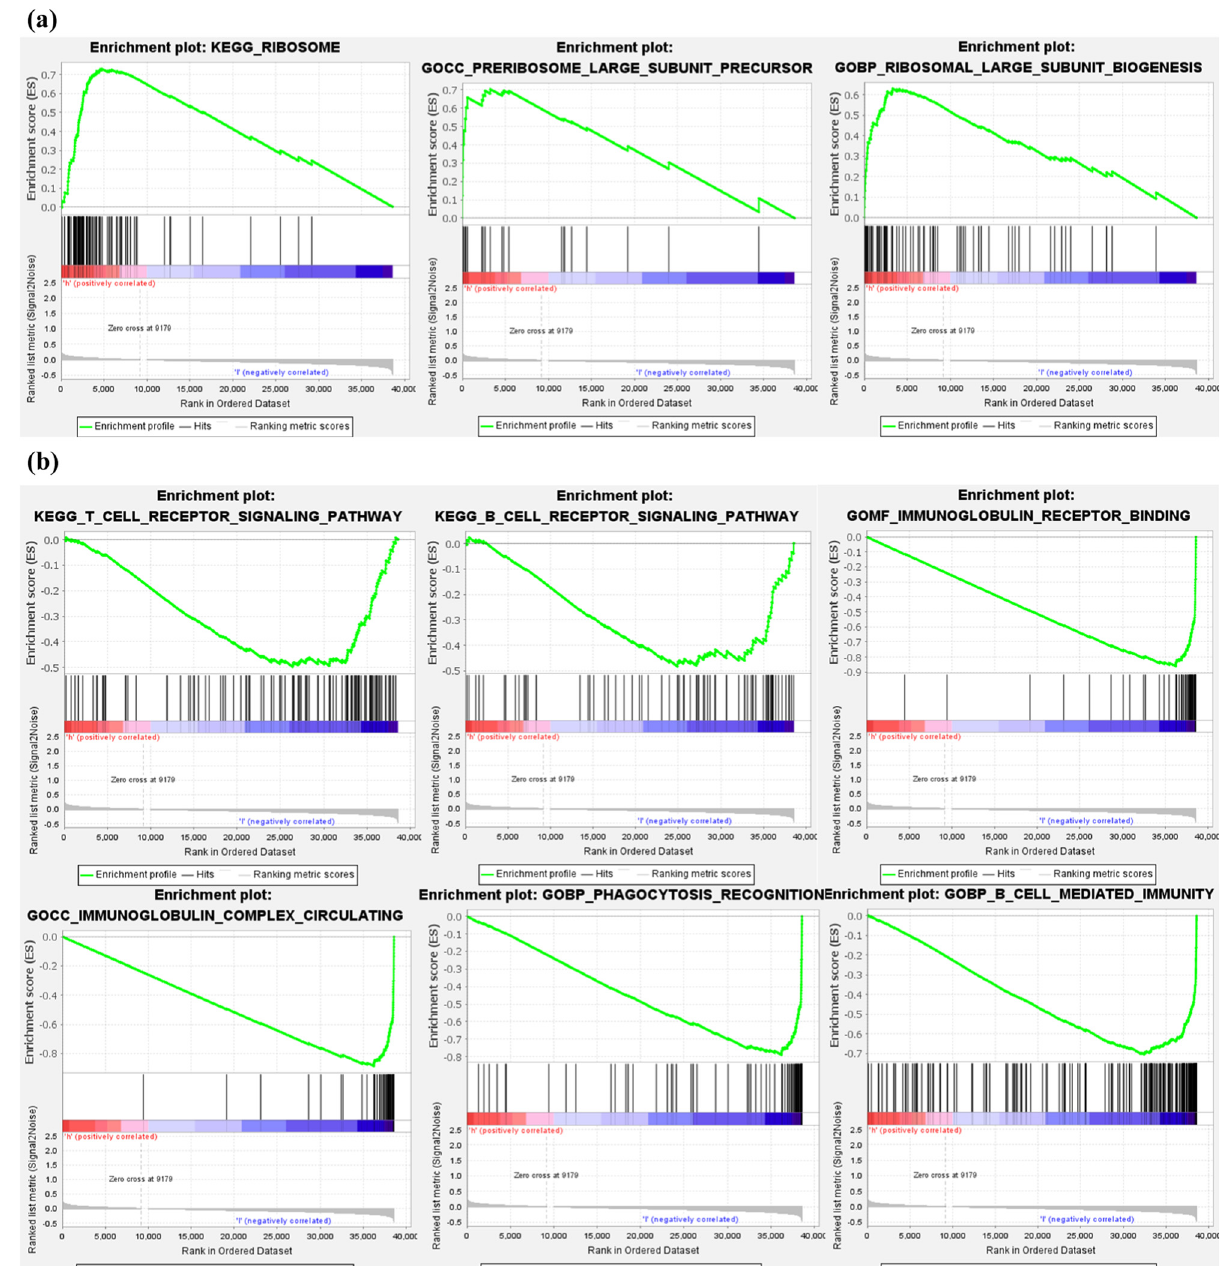
Figure 3: GSEA based on the developed signature. ( a ) GSEA results illustrate signi fi cant enrichment of ribosome - related pathways in the high - risk HNSCC patients. ( b ) GSEA results illustrate signi fi cant enrichment of immunoregulatory pathways against tumor in the low - risk HNSCC